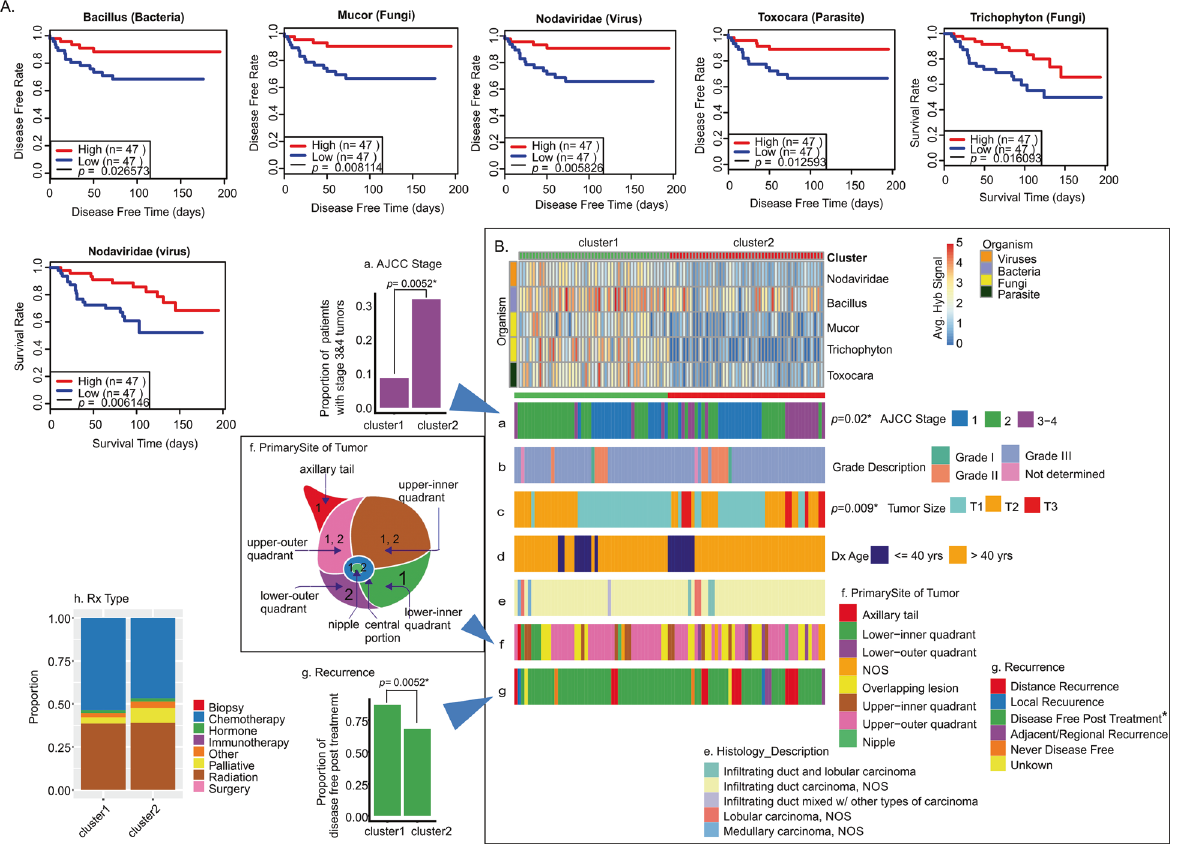
Fig. 4 Oncobiome signatures in triple-negative breast cancer where higher hybridization signals correlated with better disease outcome. A The graphs show disease-free rate and/or survival relative to high or low hybridization signals for the speci fi c microorganisms in the TN sample set. In the cases shown, higher hybridization signal correlates with increased disease-free time and/or survival. B TN BC samples were clustered based on high and low hybridization signals for those organisms where high hybridization signal correlated with higher disease-free time and survival (better outcomes). The high (cluster 1) and low (cluster 2) hybridization clusters were then correlated with clinical data shown as horizontal ( a – g ) and vertical ( h ) cluster